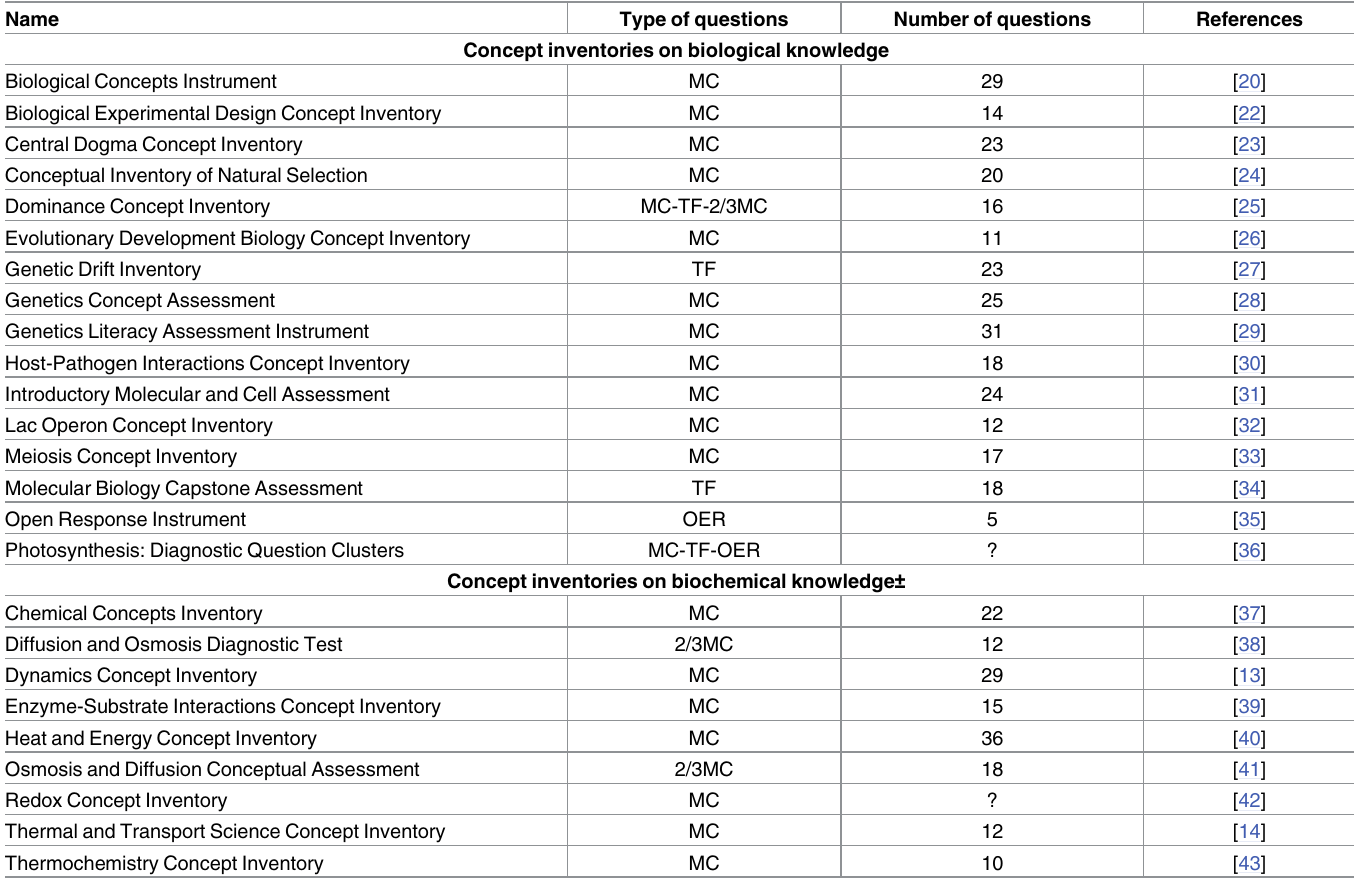
Table 1. Concept inventories covering biology or biochemistry